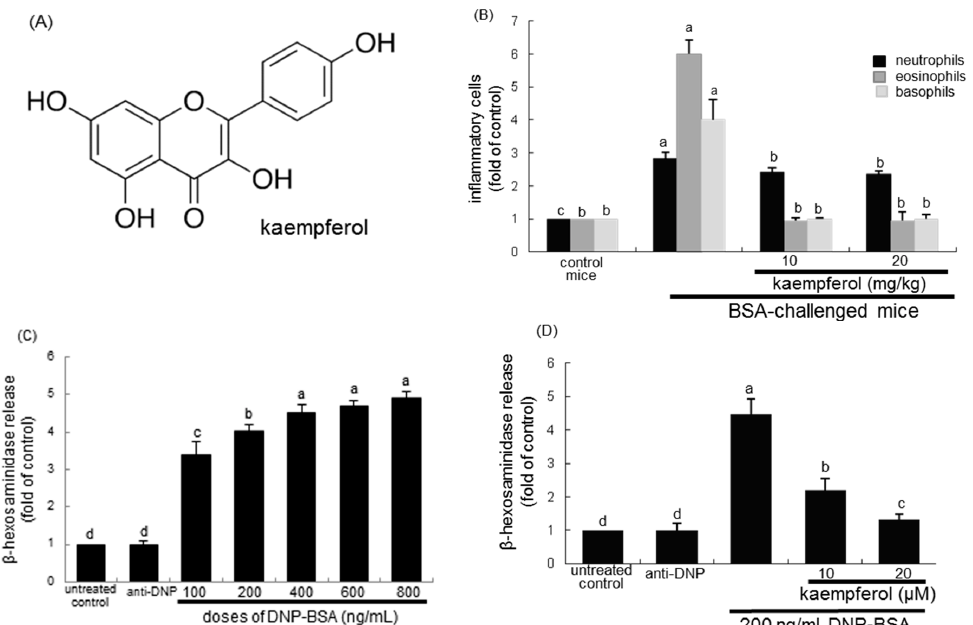
Figure 1. Chemical structure of kaempferol ( A ); reduction of inflammatory cells by kaempferol ( B ); and dose response of β -hexosaminidase release ( C ) and inhibitory effects of kaempferol on β -hexosaminidase release ( D ). For in vivo experiments, bovine serum albumin (BSA)-sensitized mice on days zero and 14 were challenged with 5% BSA aerosol on days 28, 29, and 30. The numbers of neutrophils, eosinophils, and basophils were counted in whole blood collected from sensitized BALB/c mice ( n = 6, each group) 24 h after the final challenge with BSA or phosphate-buffered saline vehicle. For the measurements of β -hexosaminidase release, rat basophilic leukemia (RBL-2H3) cells were sensitized by adding 0.5 μ g/mL anti-2,4-dinitrophenol (anti-DNP) and stimulated with 200 ng/mL DNP-bovine serum albumin (BSA) in the absence and presence of 10–20 μ M kaempferol for 72 h. Respective values (mean ± SEM, n = 3) not sharing a letter are different at p < 0.05.